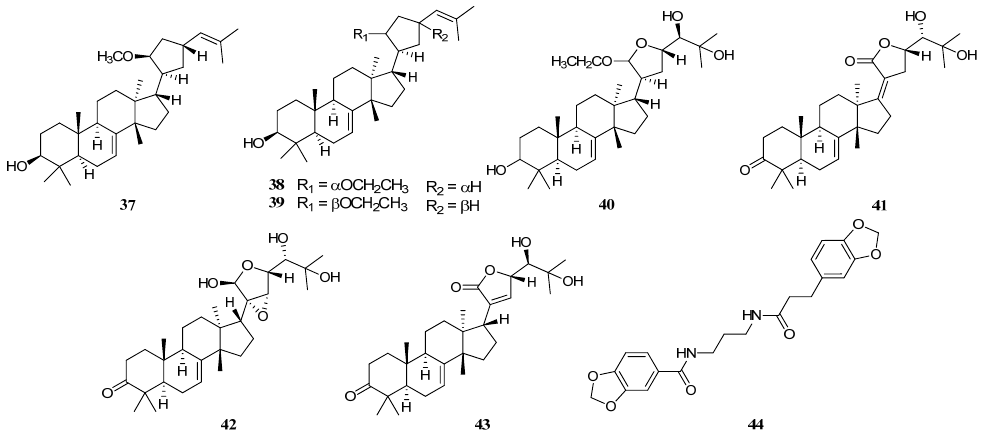
Figure 2. The molecule structures of the phytochemicals available in Picrasma quassioides.